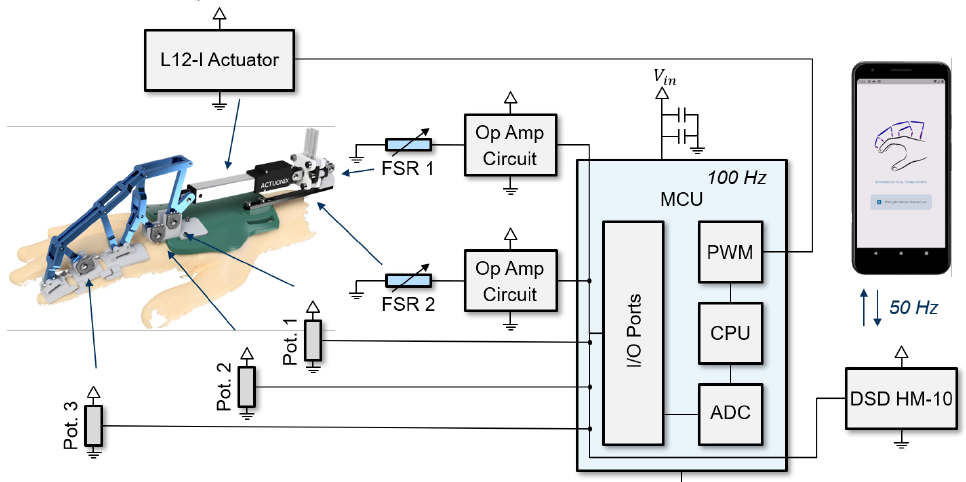
Figure 1. Overview of the electrical circuit of the extended exoskeleton by Dickmann et al. [18] and the corresponding use for the exoskeleton